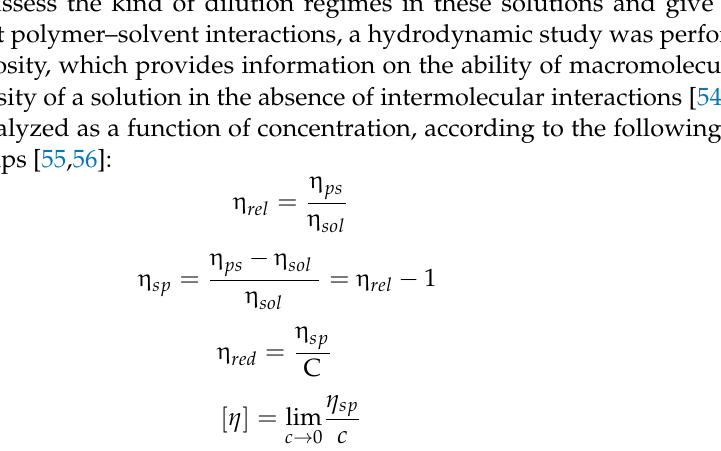
Concentration (wt.%)